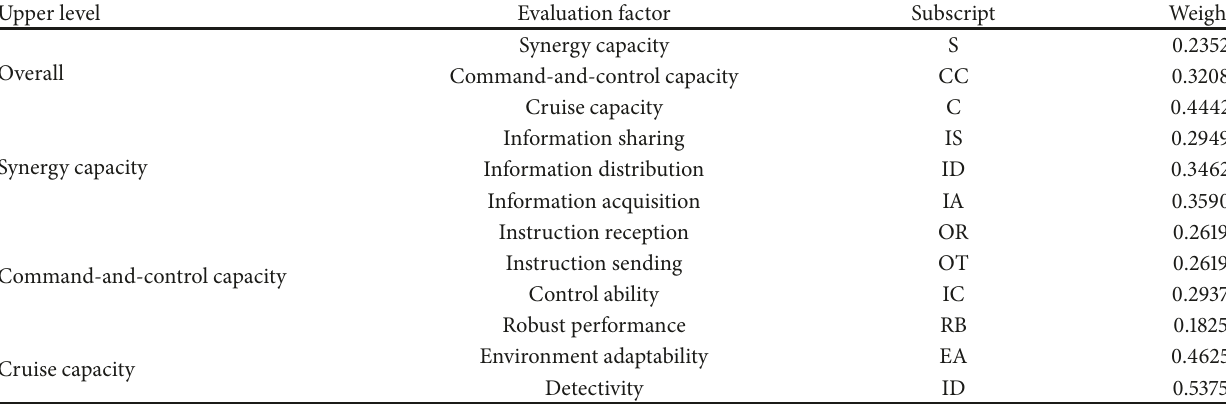
Table 2: The weights of the evaluation factors of USV-UAV synergetic